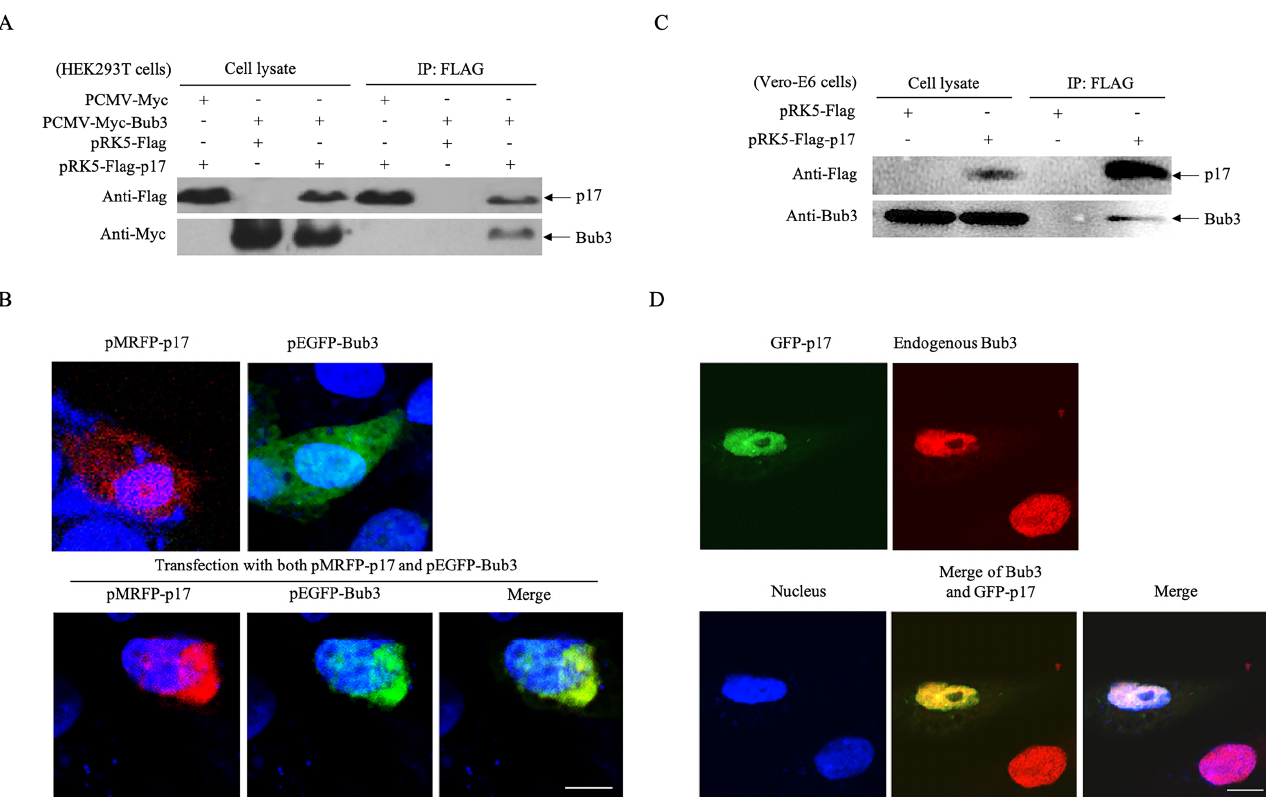
Figure 3. Interaction of ARV p17 with cellular protein Bub3. ( A ) Confirmation of the interaction of p17 with exogenous Bub3 in HEK 293T cells. Cells were transfected with the indicated plasmids. Twenty-four hours after transfection, cell lysates were prepared and immunoprecipitated with an anti-Flag antibody and immunoblotted with an anti-Flag or anti-Myc antibody. ( B ) Colocalization of exogenous p17 and Bub3 in HEK 293T cells. Cells were co-transfected with pMRFP-p17 (red) and pEGFP-Bub3 (green). Twenty-four hours after transfection, cells were fixed with 4% paraformalde- hyde and the cell nuclei was counterstained with DAPI (blue). The cell samples were observed with a confocal laser scanning microscope (magnification, × 600). The scale bar in the picture represents 5 µ m. ( C ) Interaction of p17 with endogenous Bub3 in Vero-E6 cells. Cells were transfected with the indicated plasmids. Twenty-four hours after transfection, cell lysates were prepared and immunopre- cipitated with an anti-Flag antibody and immunoblotted with an anti-Flag or anti-Bub3 antibody. ( D ) Colocalization of p17 with endogenous Bub3 in Vero-E6 cells. Cells were transfected with pEGFP-p17 plasmids. Twenty-four hours after transfection, cells were fixed with 4% paraformaldehyde and permeabilized with 0.2% Triton X-100. Then the cells were stained with a rabbit anti-Bub3 monoclonal antibody, followed by a TRITC-conjugated goat anti-rabbit antibody (red). Nuclei was counterstained with DAPI (blue). The cell samples were observed with a confocal laser scanning microscope (magnification, × 600). The scale bar in the picture represents 10 µ m.